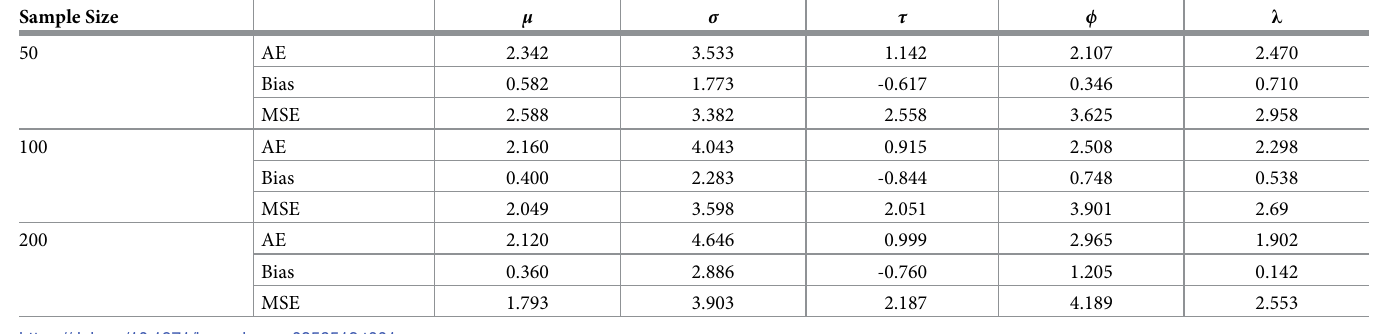
Table 1. Simulation result of MBTED(2,3,2.5,-0.7,2). Sample Size